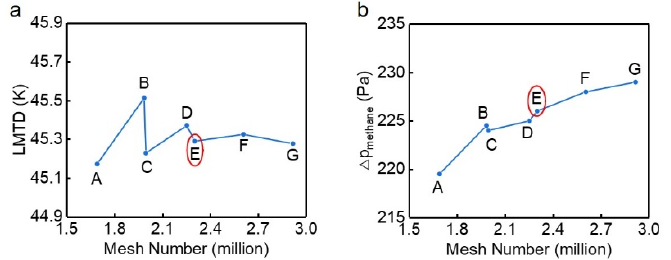
Figure 5. The numerical results with different mesh number. ( a ) LMTD; ( b ) Pressure drop in hot